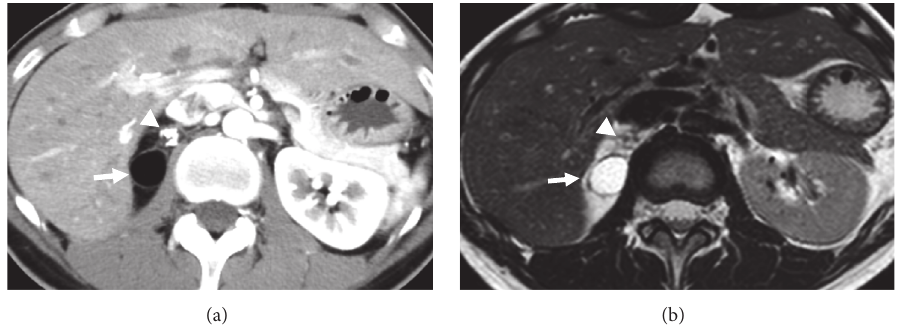
Figure 1: CT and MRI images of the tumor. Fat (white arrow) and calcification (white arrowhead) are shown in axial CT (a) and T2-weighted MRI (b) images.